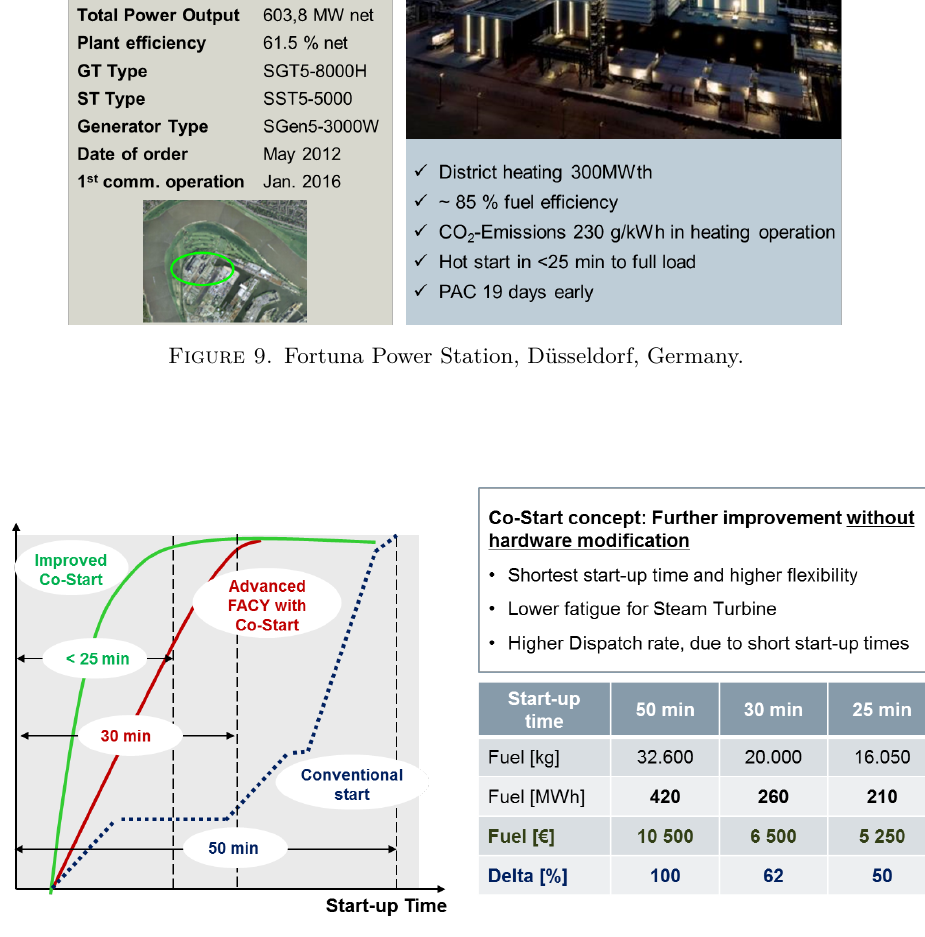
Figure 10. Hot Co-Start Test at Lausward CHP Station.